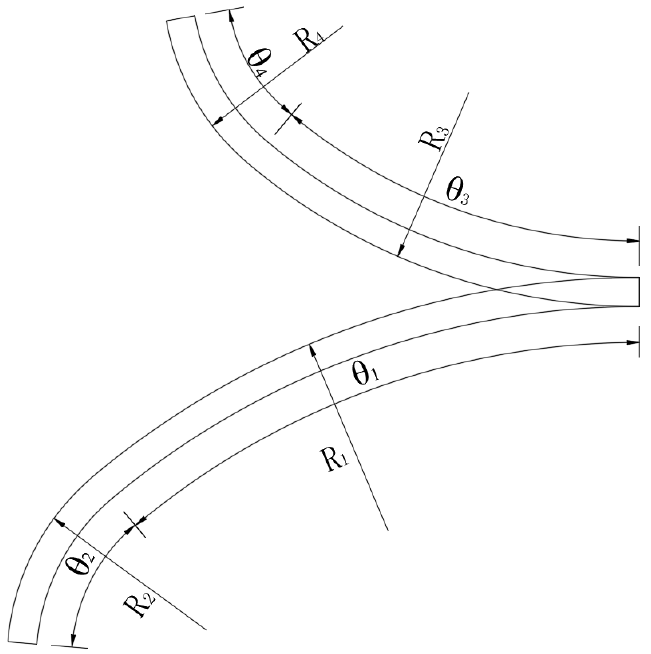
Figure 6. Diagrammatic sketch of the geometric parameters of the training wall.